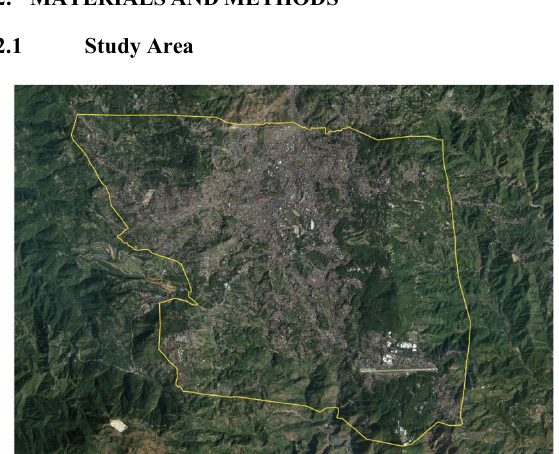
Figure 1 . Google satellite image showing the administrative boundary (yellow) of Baguio